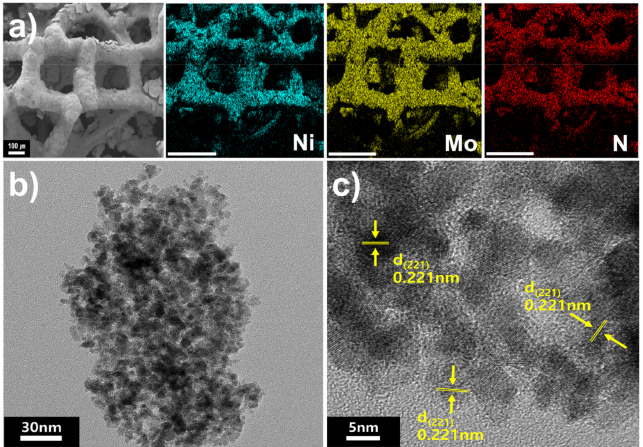
Figure 1. ( a ) SEM image of Ni 2 Mo 3 N/NF and SEM-EDS elemental mapping images (scale bar = 300 µ m). ( b , c ) TEM images of Ni 2 Mo 3